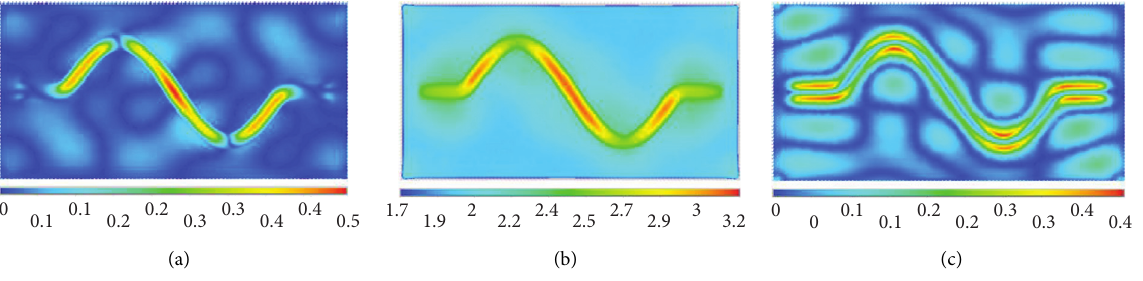
u u x , (b) y , and (c) z .